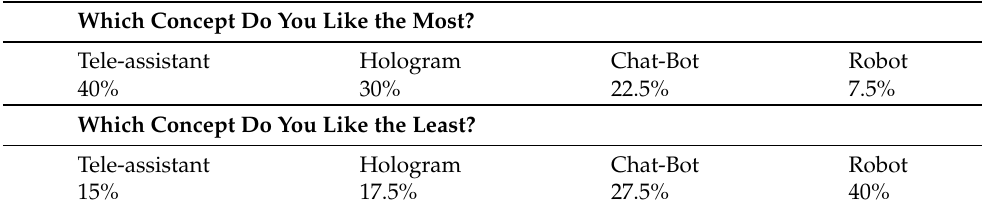
Table 2. Descriptive Statistics: Preference for Digital Companions.